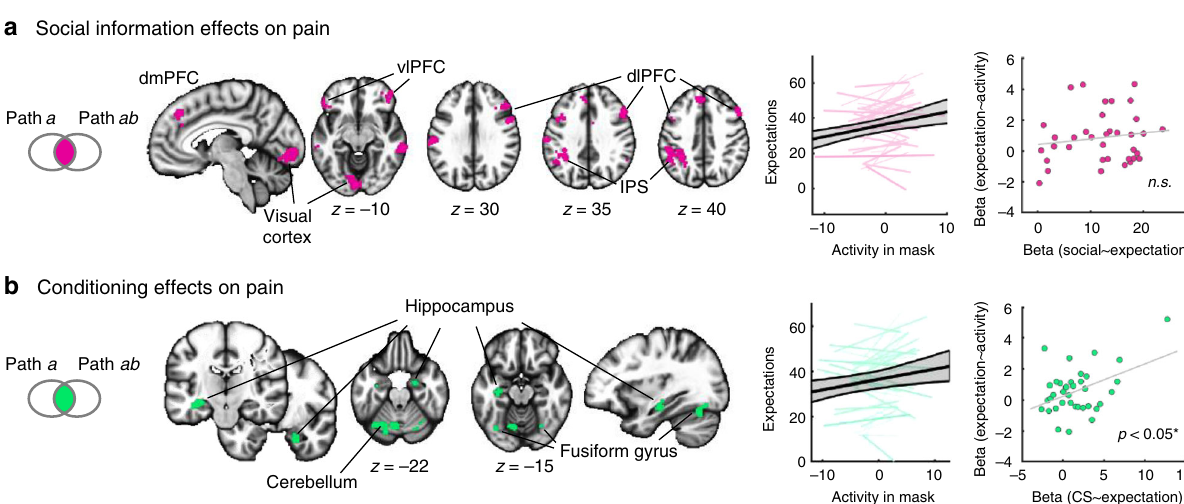
Fig. 2 Whole brain mediation analysis. a Overview. A mass-univariate mediation analysis was performed to identify: (1) activity increases for high > low social information and CS (Path a ), (2) activity associated with increased pain ratings when controlling for path a effects (path b ), and (3) activity formally mediating the effects of social information and CS on pain ratings (dashed arrows, path ab ). b Path b effects. Signi fi cant pain-related activity independent of the experimental manipulations was found in mid cingulate, posterior and mid insula, thalamus, cerebellum, and other regions. The wedge plot (with the radius of each wedge proportional to the correlation strength) indicates a high spatial correlation of this effect with the Somatomotor network (Pearson correlation coef fi cient r = 0.28, see Supplementary Table 6). The ten most strongly associated Neurosynth terms are shown on the right (decreasing brightness indicates order of associations, see Supplementary Table 7). c Path a effects for Social (purple), CS effects (green), and their conjunction (blue). Social information effects (increased activity for Social HIGH > Social LOW ) were found in ACC, anterior insula, dlPFC, and parietal areas. Those effects most strongly mapped on the frontoparietal ( r = 0.13) and dorsal attention networks ( r = 0.12, see wedge plot and Supplementary Table 6) and were associated with terms re fl ecting cognitive tasks (see Supplementary Table 7). CS effects (CS HIGH > CS LOW ) were seen in limbic areas and cerebellum, and showed a more diffuse mapping on large-scale networks and meta-analytic terms. d Path ab effects for Social (purple), CS effects (green), and their conjunction (blue). Social in fl uence effects on pain mapped on the frontoparietal and dorsal attention networks (both r ’ s = 0.06) and on terms associated with cognitive control. CS effects mapped on the default mode network ( r = 0.06) and were associated with terms related to semantic processing. All maps were thresholded at FDR q < 0.05 corrected for multiple comparisons across the whole brain (gray matter masked) with adjacent areas thresholded at p < 0.01 and p < 0.05 (uncorrected) for display